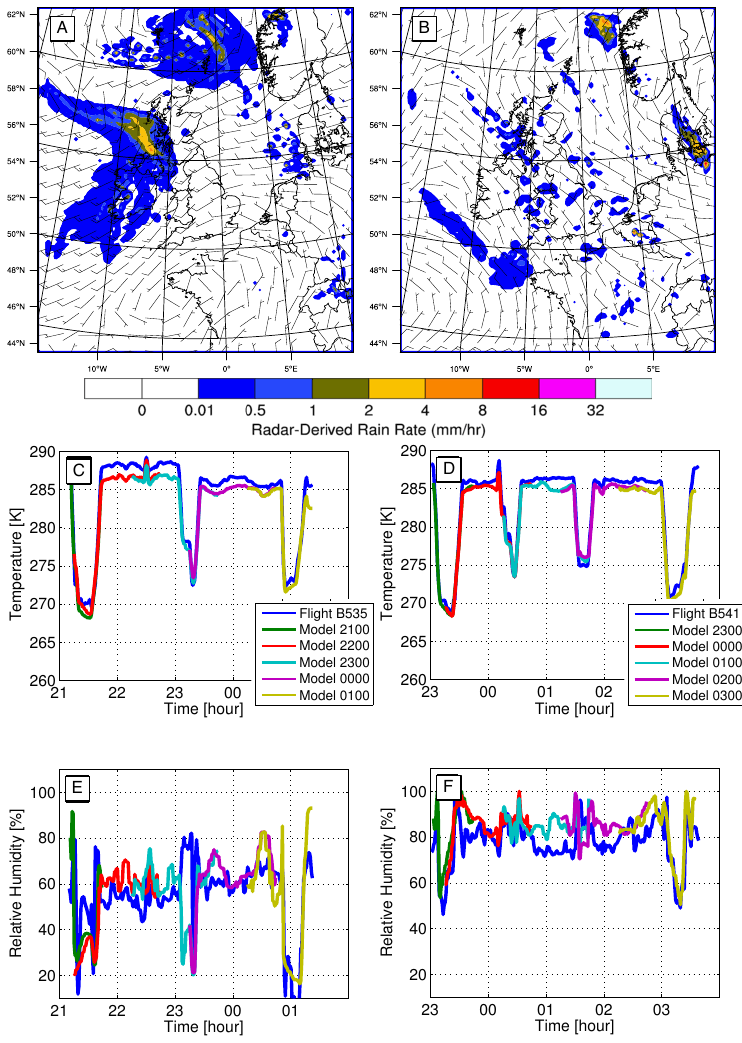
Figure 3. Meteorological fields for flights B535 ( a , c , and e ) and B541 ( b , d , and f ). ( a ) and ( b ) show the simulated radar-derived rainfall rates (and wind fields at 960hPa) from the model, at 00:00UTC on 18 July and 00:00UTC on 29 July, respectively. ( c ) and ( d ) compare measured (blue lines) and modelled (multi-coloured lines) air temperature along the flight paths of B535 and B541, respectively. Modelled data are extracted from hourly output files – see main text for details. ( e ) and ( f ) compare measured and modelled relative humidity along the flight paths of B535 and B541,